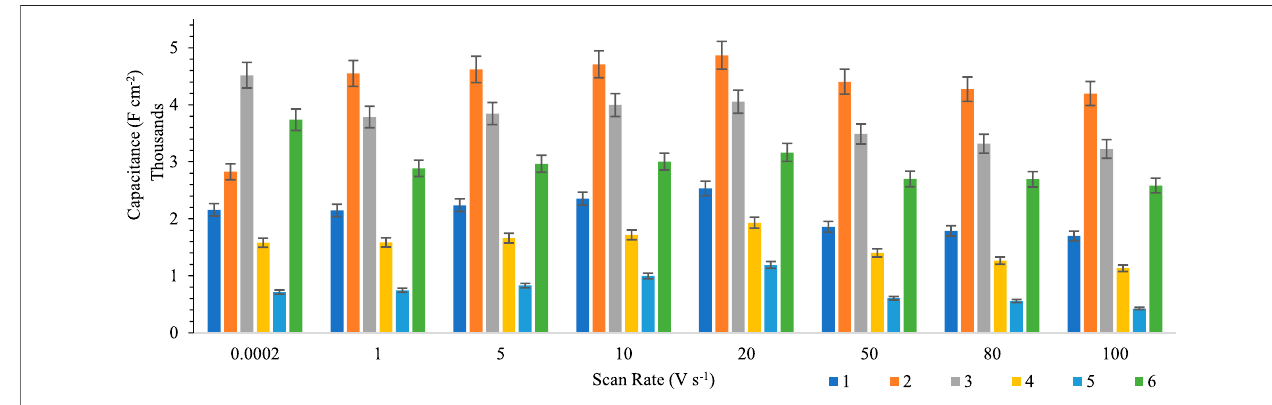
FIGURE 4 | Comparison between the scan rate effects on the capacitance stability of helminth eggs for fi ve independent repeats during implanting of three microelectrodes with 0.0124 ± 0.0008 mm interelectrode distance, error bar: ± standard deviation ( n (cid:2) 5).